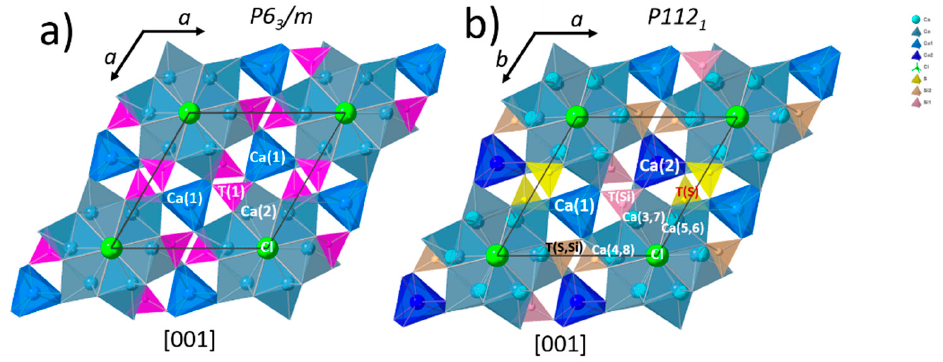
Figure 2. ( a ) Hexagonal structure of Ca 9.82 (SiO 4 ) 3 (SO 4 ) 3 Cl 1.64 (ICSD: 262245: [20]); ( b ) monoclinic structure of Ca 9.94 (SiO 4 ) 3 (SO 4 ) 3 (O H) 1.2 O 0.5 Cl 0.32 (ICSD: 39775, [19]). For explanation see